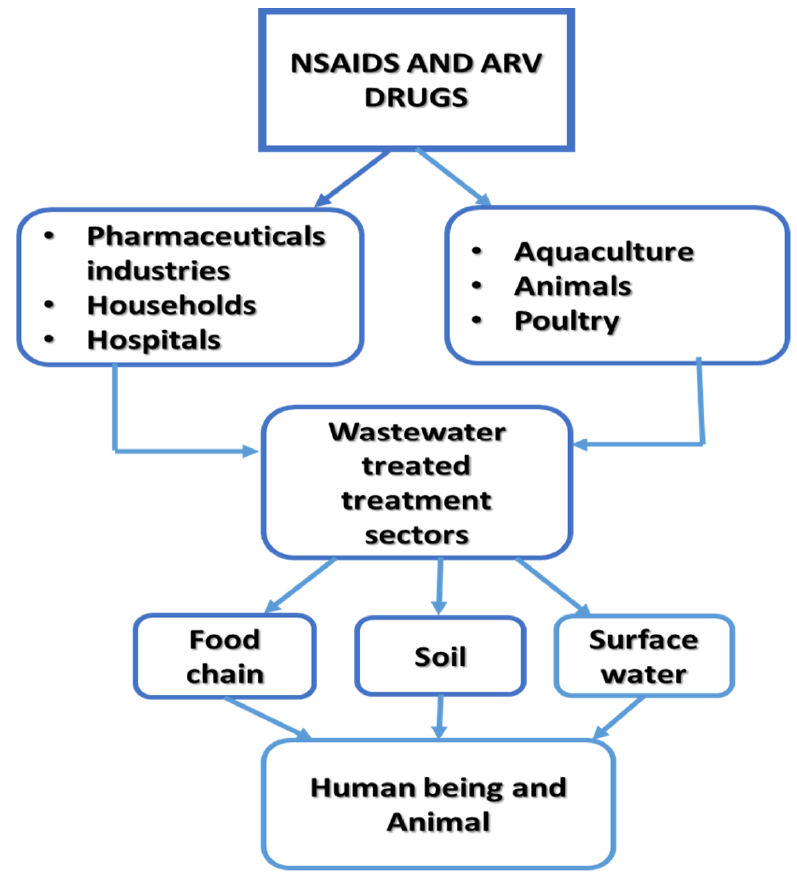
Figure 2. Sources of pharmaceuticals pollutants.